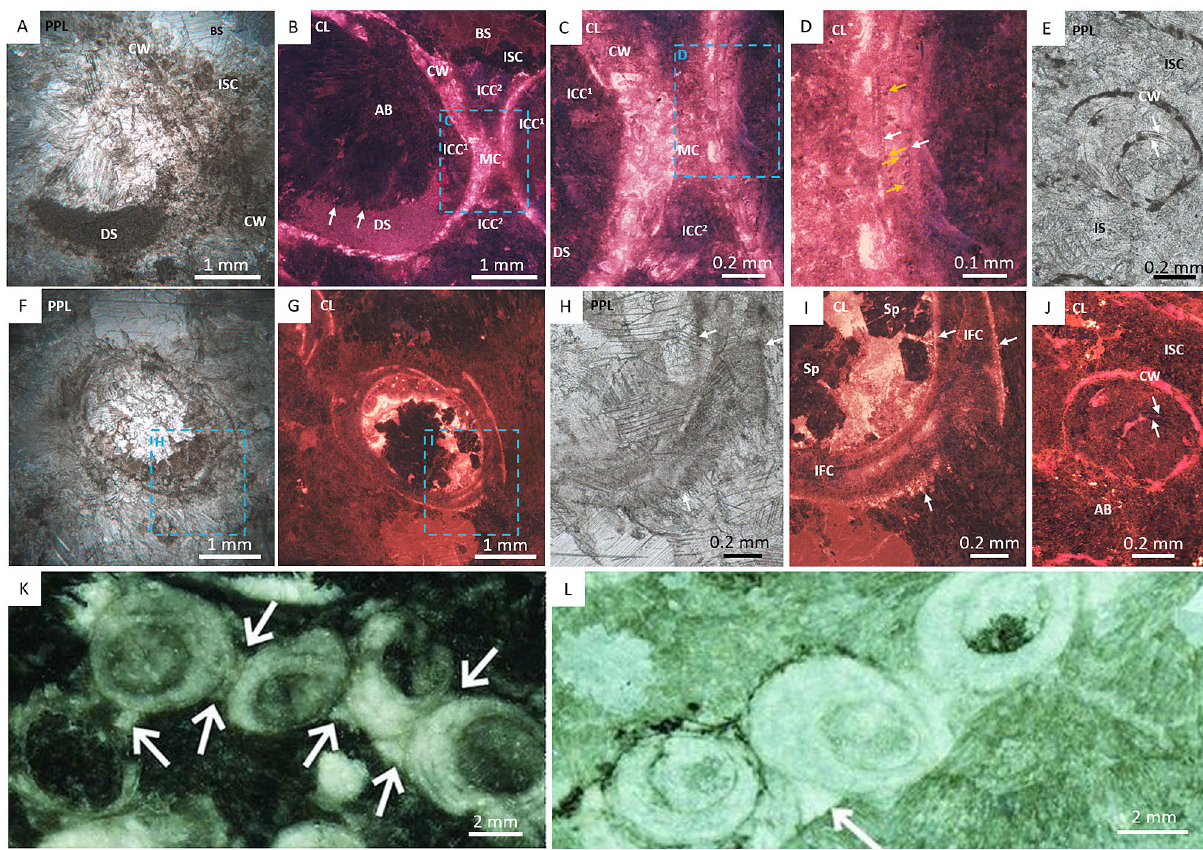
Figure 3. Photomicrographs of Cloudina hartmannae and Cloudina riemkeae from Driedoornvlakte, Upper Omkyk Member, Nama Group. ( A ) PPL of attached Cloudina with a dolomitised wall (CW) and filled with dolomitised sediment (DS), followed by an inclusion-rich sparry calcite (ISC) and a later clear burial spar (BS). ( B ) CL image of A, intra-cloudinomorph cement (ICC 1 ) nucleated from the inner Cloudina wall and inter- cloudinomorph cement (ICC 2 ) formed between the Cloudina tubes and nucleated from the outer wall and including the mutual cement (MC) which has the same luminescence as CW. Non-luminescent pseudomorphed aragonitic botryoids (AB) nucleate from ICC 1 . These are proceeded by ISC and BS. ( C ) Inset of B, showing ICC 1 and ICC 2 -cements with same luminescence. ( D ) Inset of C, showing bright luminescent CW with multiple non- luminescent laminae (white arrows) with small aragonitic needles (orange arrows) nucleating from laminae. ( E ) PPL of Cloudina with a dolomitised wall (CW) composed of laminae (arrowed) with thin sparry calcite infill between the two laminae, surrounded by inclusion-rich sparry calcite (ISC). ( F ) Transverse PPL of dolomitised individual. ( G ) CL of C. ( H ) Inset of F, of broken, dolomitised Cloudina wall (arrowed). ( I ) Inset of G in CL, of broken bright luminescent Cloudina wall (arrowed) exposing the inter-funnel cement (IFC). The rest of the tube is infilled with non-luminescent spar (Sp). ( J ) CL of E, with dull luminescent cements (arrowed) highlighting cements between the laminae and is surrounded by ISC. AB nucleate from the CW. ( K ) from Penny et al. 27 . Polished slab highlighting inter-cloudinomorph cements (arrowed) between multiple Cloudina individuals. ( L ) From Penny et al. 27 . PPL image of inter-cloudinomorph cements (arrowed) situated between Cloudina individuals from which botryoids nucleate. Figure created in PowerPoint,